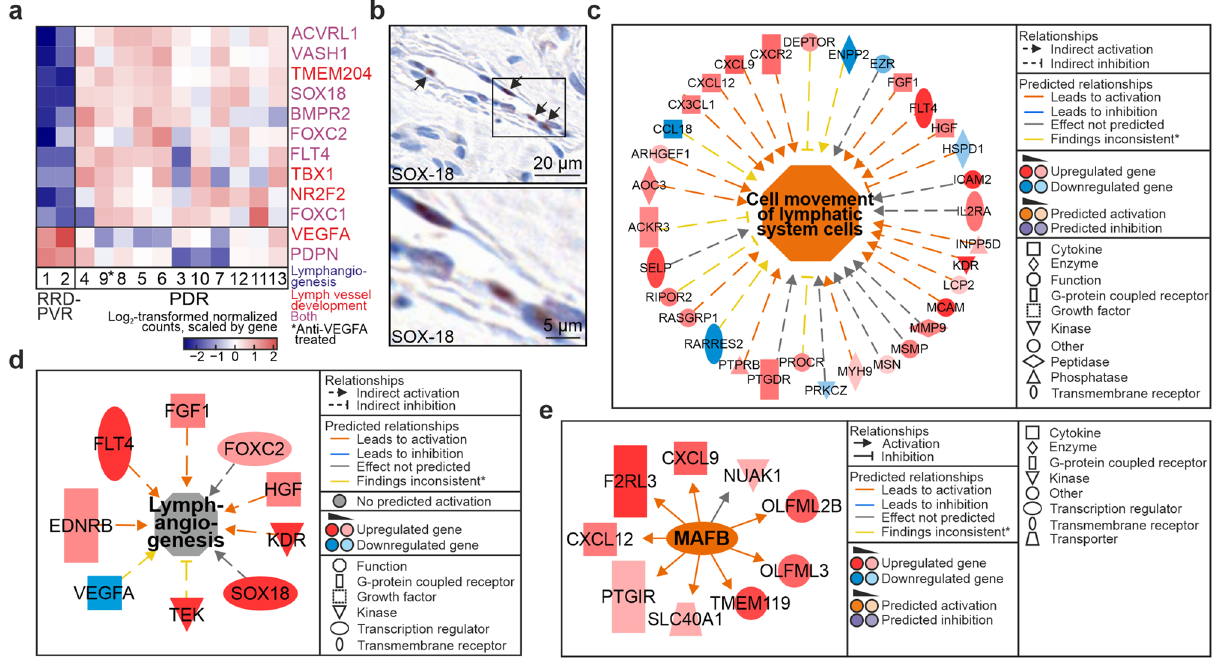
Figure 5. Genes and processes related to lymphatic development are overrepresented in proliferative diabetic retinopathy. ( a ) Heatmap of log 2 -transformed normalized read counts of DEGs in GO-terms Lymph vessel development and Lymphangiogenesis . (*) Patient treated with intravitreal anti-VEGFA. ( b ) Representative light micrographs of immunohistochemistry of nuclear SOX-18 in PDR fibrovascular tissue. Scale bars, 20 µm (upper), 5 µm (lower). ( c ) Network of DEGs based on which IPA function Cell movement of lymphatic system cells was predicted to be activated. ( d ) Network of DEGs based on which IPA function Lymphangiogenesis